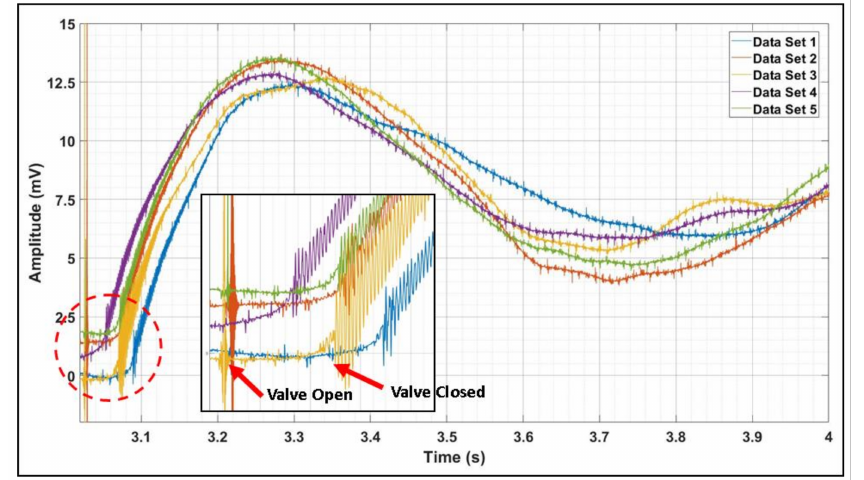
Figure 8. 1 mm active leak, 4 bar water pressure, raw data from laboratory scale test